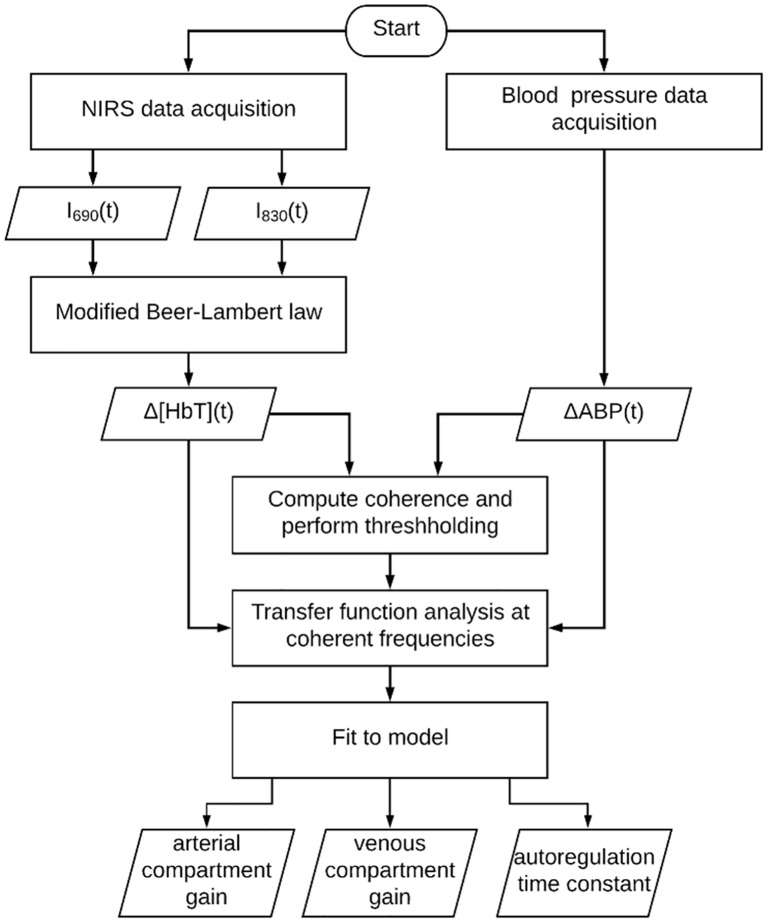
Flow chart of data collection and analysis.I690(t) and I830(t) are the light intensities detected at 690 nm and 830 nm, respectively. Δ[HbT](t) is the relative change in total hemoglobin concentration. ΔABP(t) is the change in arterial blood pressure relative to baseline.